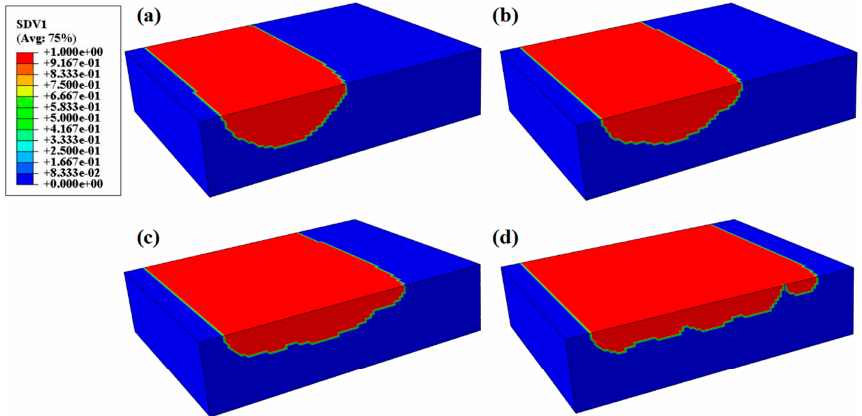
Figure 7. The solidified development at end of the process: ( a ) 75 µ m, ( b ) 100 µ m, ( c ) 150 µ m, and ( d ) 200 µ m.